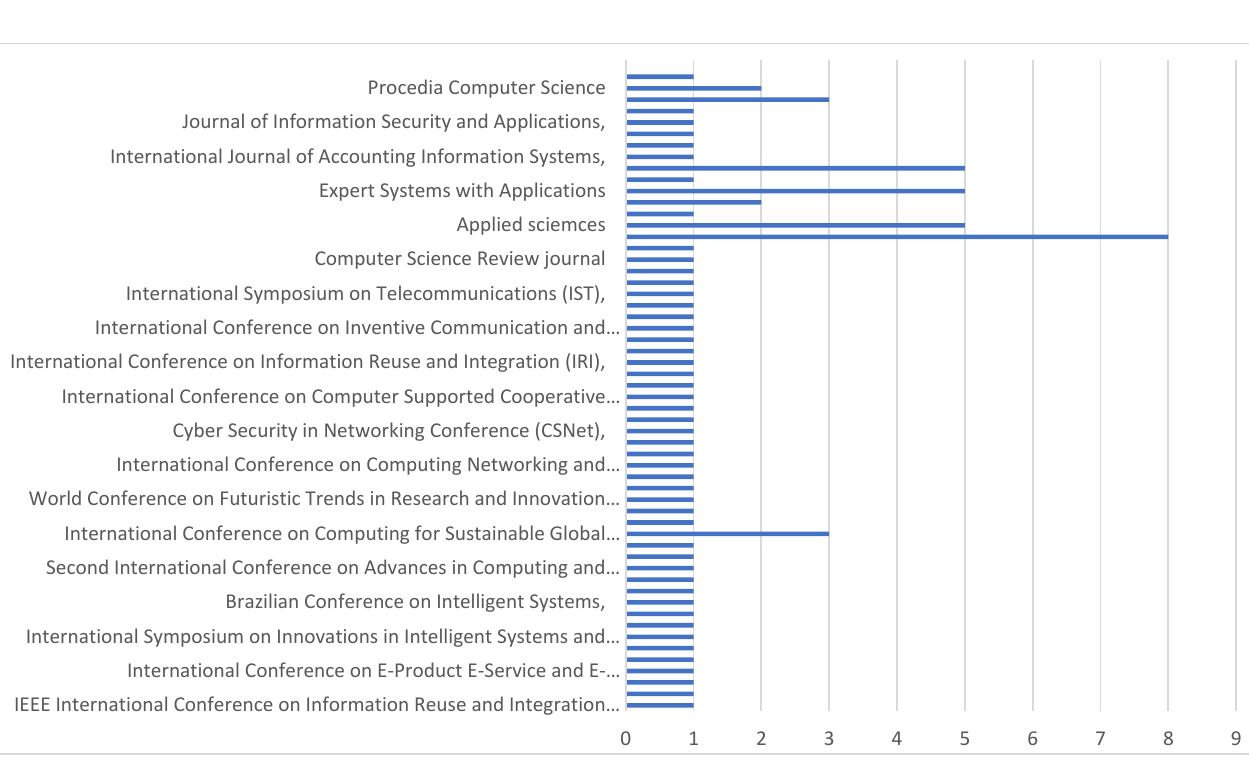
Figure 3. Number of articles per journal.